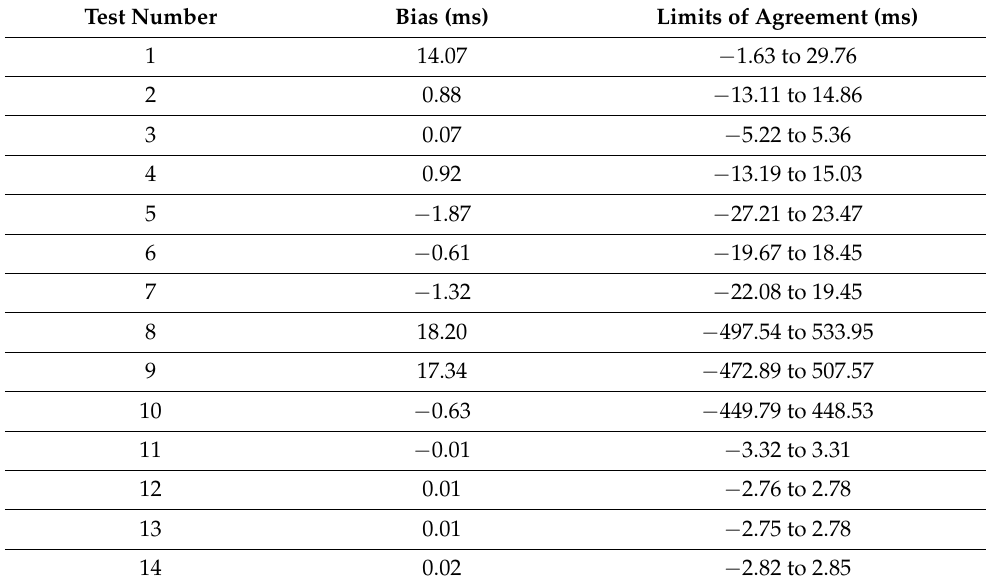
Table 4. Bias and limits of agreement from the tests. Bland-Altman plots corresponding to this table are given in Figures 1 and 2, and in Figures S1–S14 in the supplementary